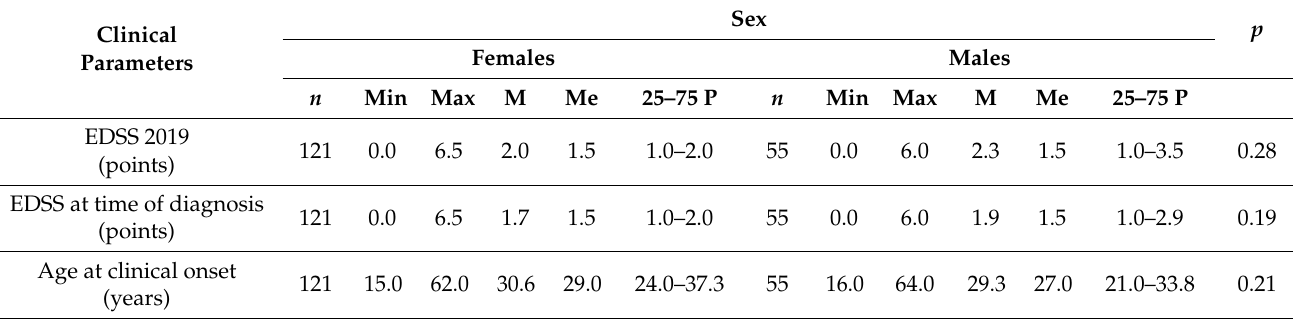
Table 1. Study group characteristics.